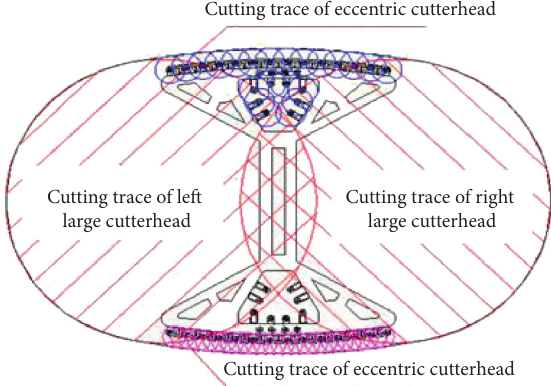
Cutting trace of eccentric cutterhead